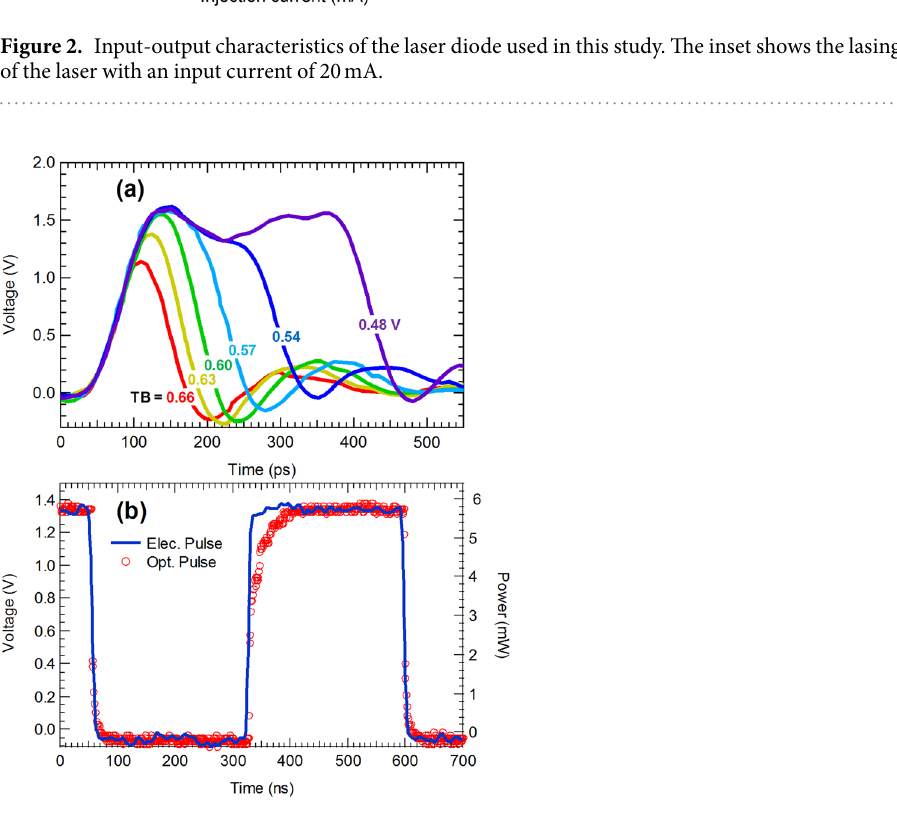
From Fig. 4(a,d), we see that reducing the electrical pulse duration simultaneously reduces (or cuts) the steady state durations of the optical pulses, even though the delay time of the optical pulses remains unchanged. That is to say, the optical pulse width is adjusted by tuning the electrical pulse width. Figure 4(d) shows that this steady state can be significantly reduced, leaving only the initial spike of the optical pulse, which has a minimum pulse-width of approximately 100 ps. The intrinsic minimum duration of the first spike depends on the gain and structural properties of the semiconductor laser diode and can further be reduced by optimizing the parameters of the laser diode. The inset shows an enlarged figure of the waveform of the first spike, indicating that the wave- form contains many jitters. Further experiments on jitter measurements (See Supplementary Information) have been performed. Figure 5(a), shows the phase noises of the input and output signals of the CMOS pulser, respectively. The rms jitters are 34.208 ps and 39.450 ps, respectively, which means the extra jitter contribution by the pulse generator circuit is only 5.242 ps. Meanwhile we also measure the phase noise of the input pulse and the optical outputs of